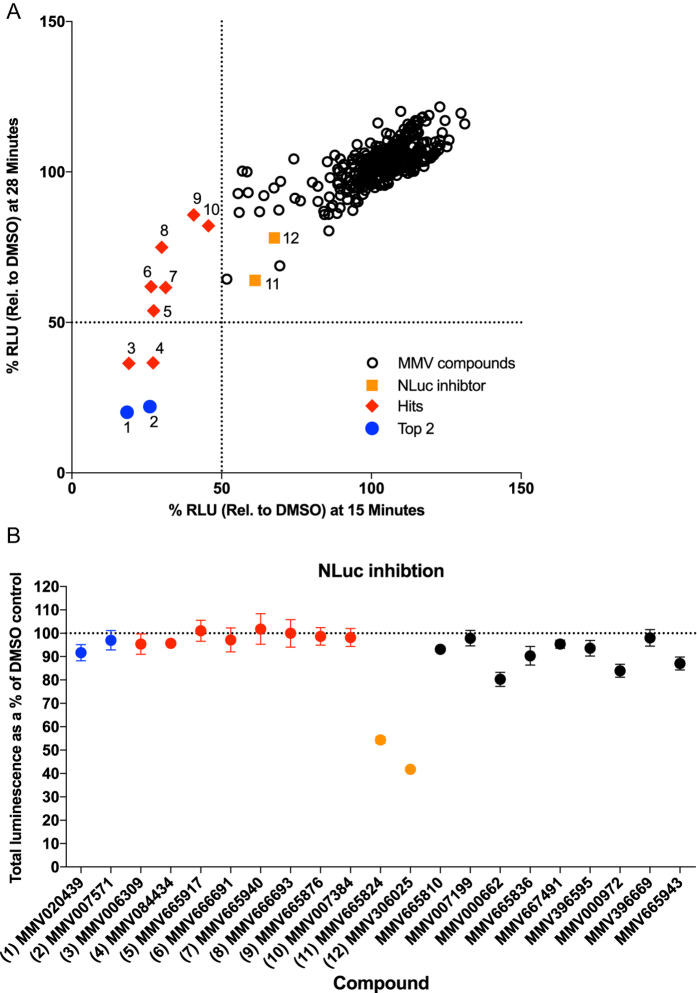
Sorbitol induced lysis of Plasmodium falciparum parasites expressing Nanoluciferase (NLuc) following pre-treatment with the 400 MMV Malaria Box compounds.(A) Inhibition of lysis by MMV Malaria Box compounds was quantified by the activity of NLuc released following sorbitol lysis and was expressed as relative light units (RLU) relative to DMSO control. (B) Counter screen of top 20 NPP inhibitors from the MMV Malaria Box. Inhibition of NLuc was measured by adding the MMV compounds to parasites that had been lysed in water. Two compounds MMV665824 and MMV306025 strongly inhibited NLuc activity. Colours and numbers in (A) correspond to those in (B).